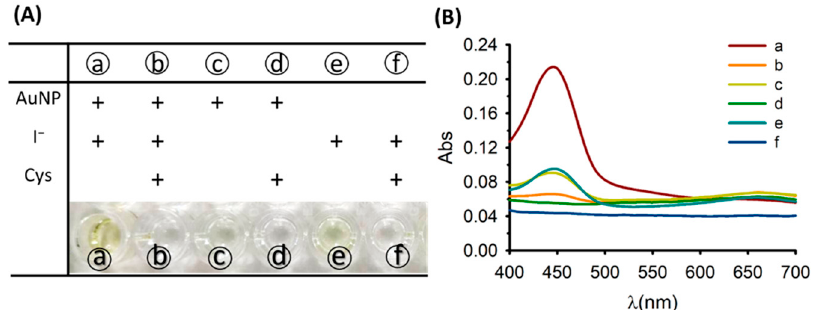
Figure 1. ( A ) Color changes of the solution under different conditions. The “+” indicates the presence of the corresponding substance. ( B ) Absorption spectra of the catalytic AuNP solution under different conditions. The final concentrations of I − and cysteine were 5 μ M and 50 μ M, respectively.